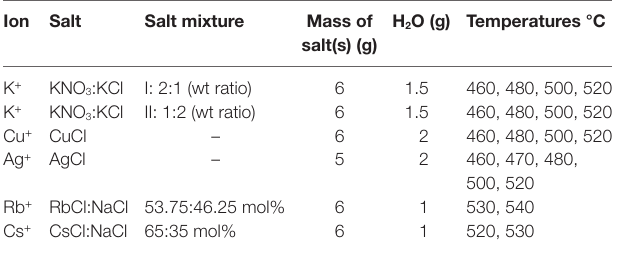
taBLe 2 | ion-exchange treatments.